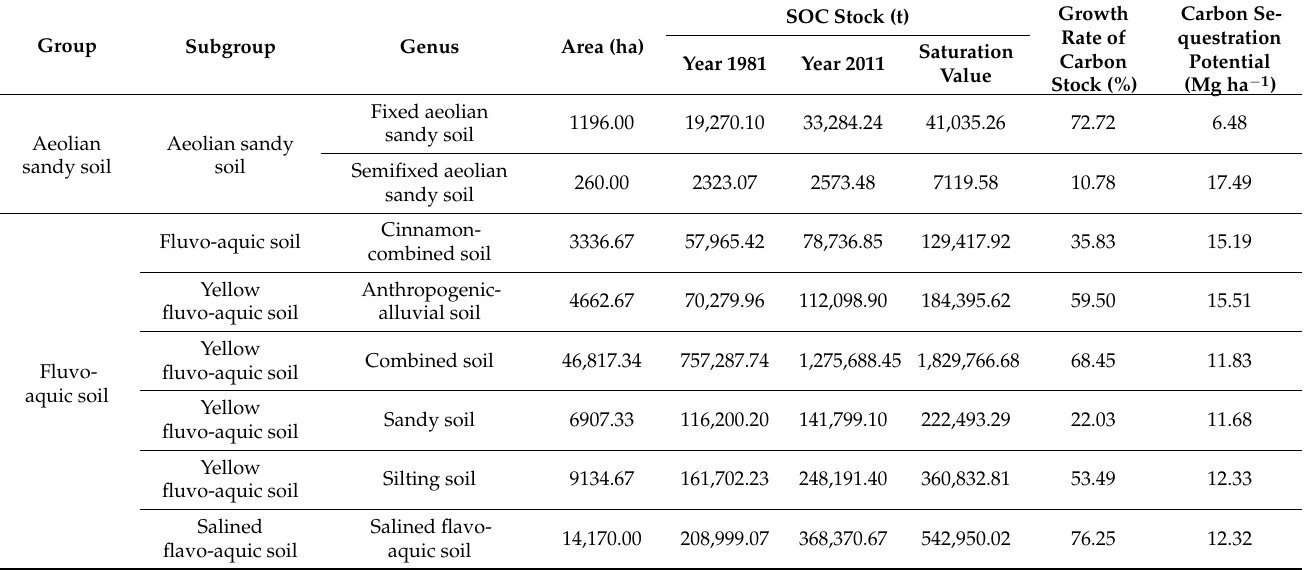
Table 2. The amount and change of SOC stock in different soil